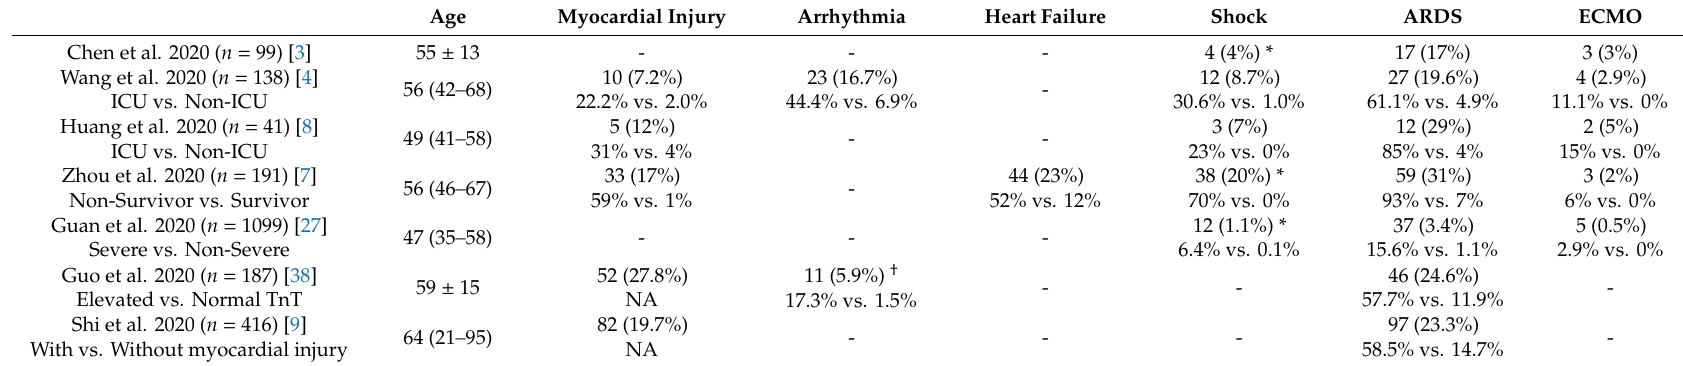
Table 2. Prevalence of Cardiovascular Complications, Acute Respiratory Distress Syndrome (ARDS), and Extracorporeal Membrane Oxygenation (ECMO) in COVID-19